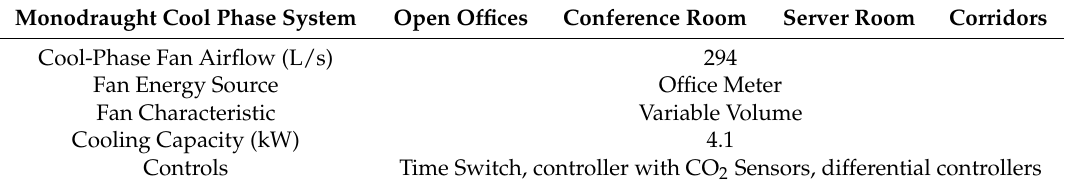
Table 12. Design variables for the Monodraught Cool Phase system.